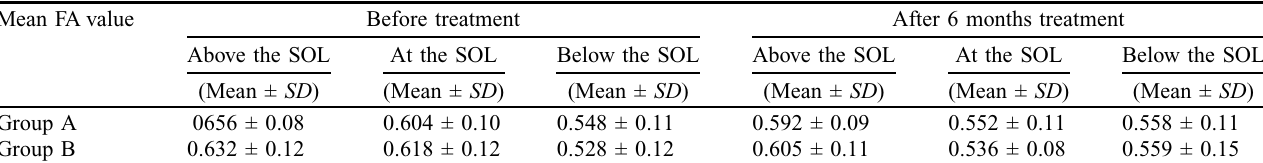
Table 1. Mean FA values in groups A and B.